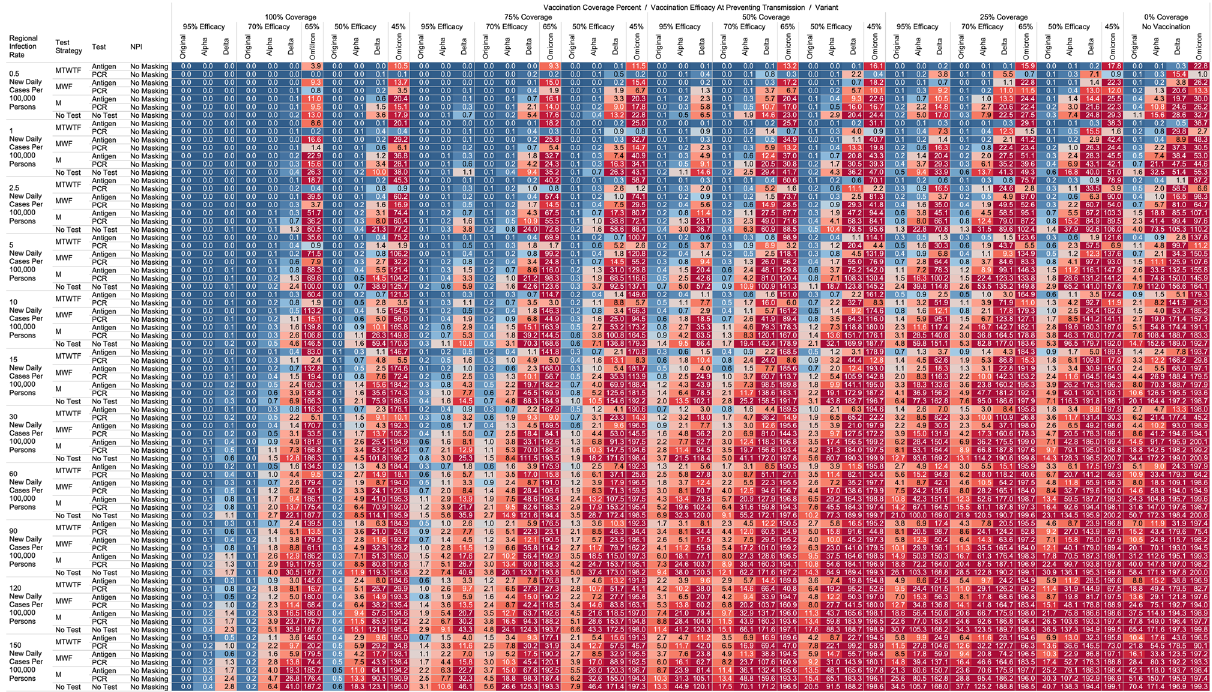
Figure 4. Heatmap of simulated workplace-acquired infections through 4800 person weeks with testing performed in all workplace members and with no masking intervention. The sensitivities of PCR and antigen tests a variant specific as outlined in Table 1.